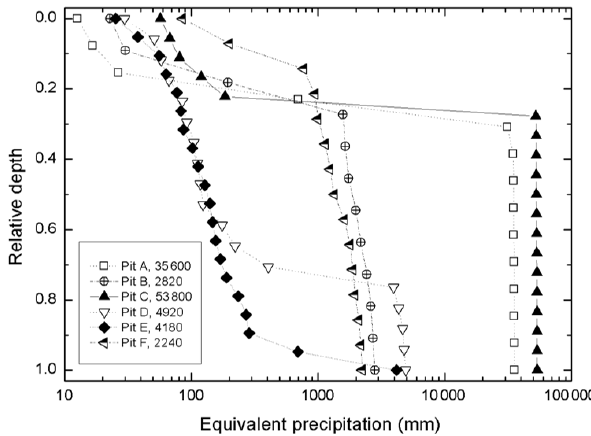
Figure 4. Equivalent precipitation for each pit based on a constant deposition EC ∗ y in fresh snow as a function of the relative depth of the pit from top to